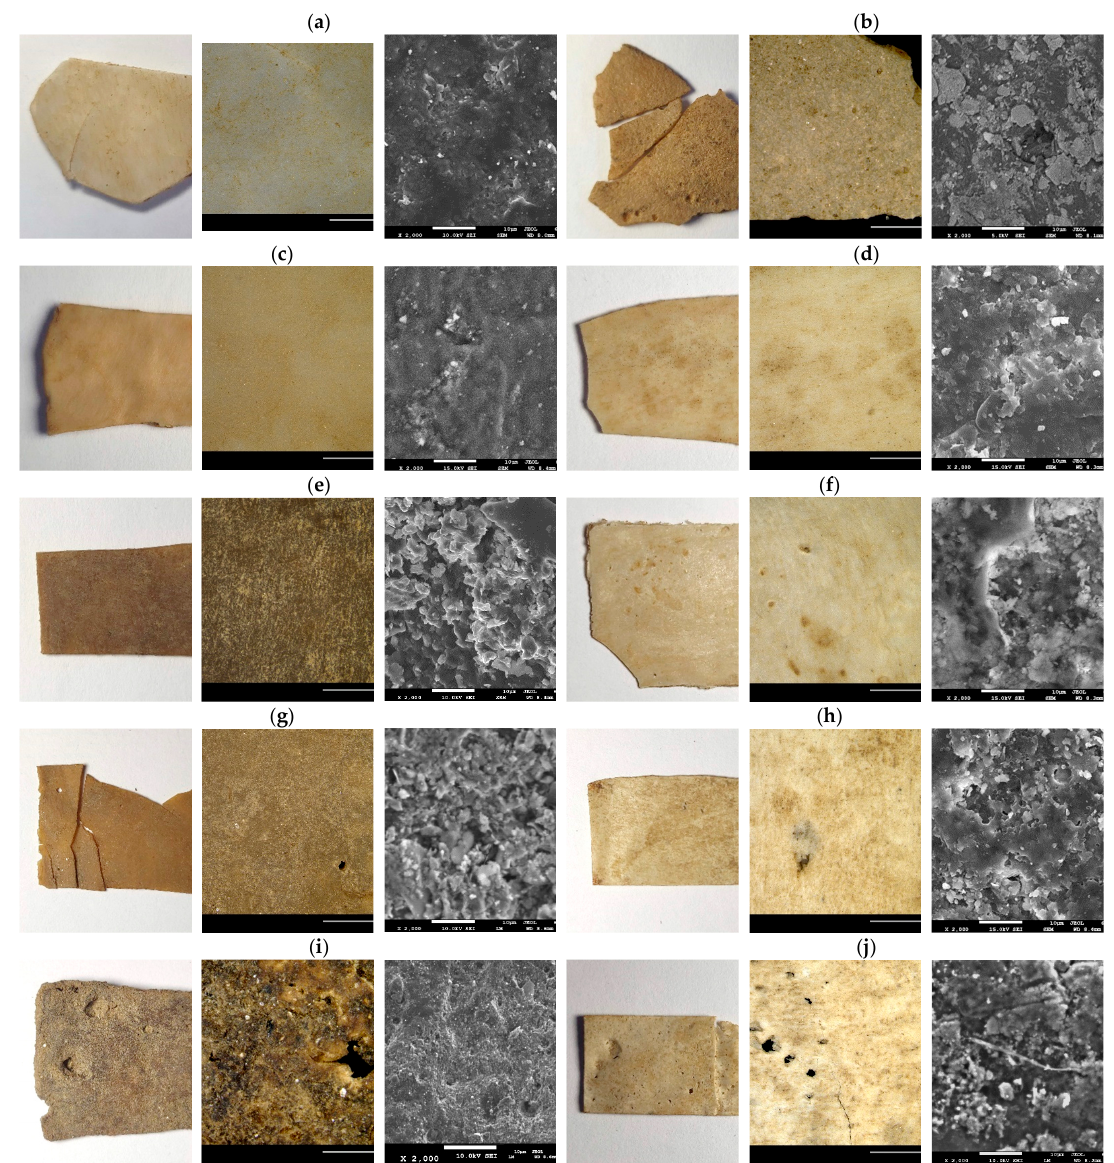
Figure 9. The surfaces of the materials after 7 months of soil degradation. From left to right: mac- roscopic photograph, stereoscope image with ×7.5 magnification and SEM image with ×2000 mag- nification. Reactive blending. ( a ) PLA; ( b ) PBAd; ( c ) PBF; (d) PBF PLA; ( e ) PBF-PBAd 75 25; ( f ) PBF-PBAd 75 25 PLA; ( g ) PBF-PBAd 50 50; ( h ) PBF-PBAd 50 50 PLA; ( i ) PBF-PBAd 25 75; ( j ) PBF- PBAd 25 75 PLA.